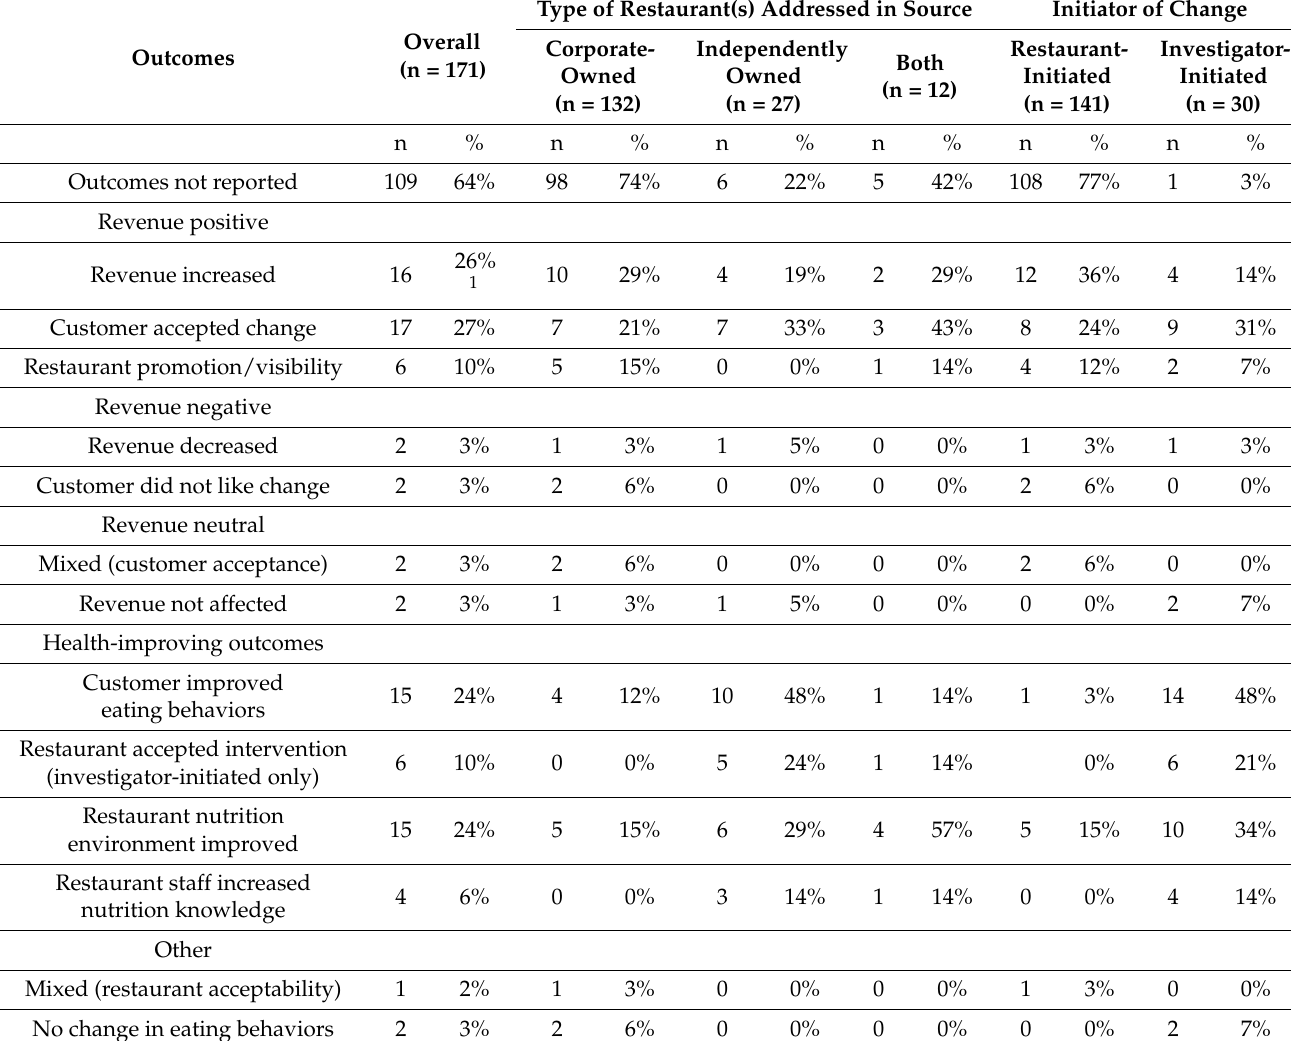
Table 4. Reported outcomes, overall and stratified by restaurant type, addressed and change initiator.